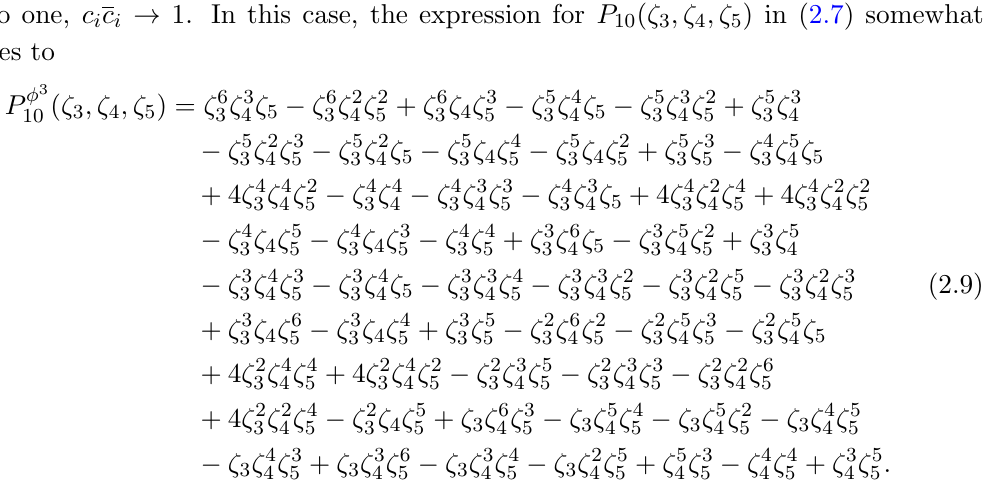
( (cid:16) 3 ; (cid:16) 4 ; (cid:16) 5 ) = 0 for (cid:16) 5 = 1 10